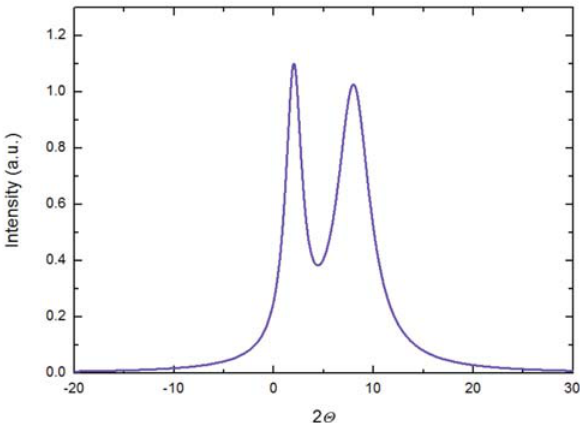
Figure 3. Two overlapped profiles, defined by Gauss functions.